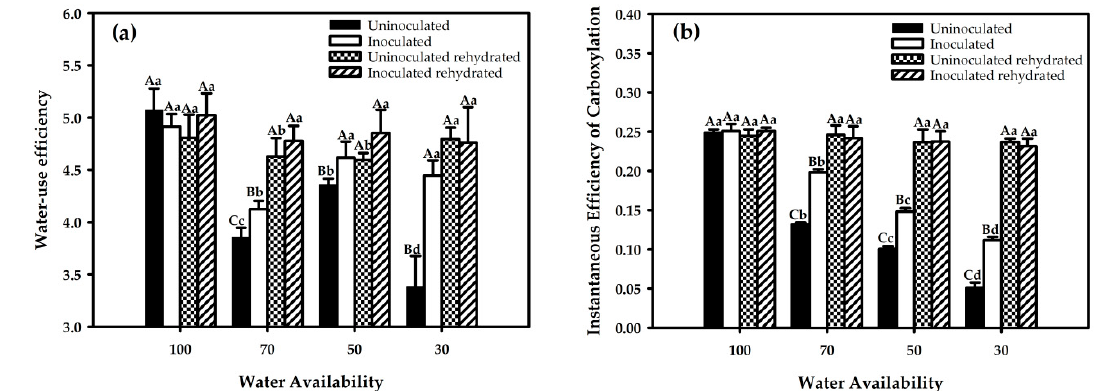
Figure 2. Gas exchange in red rice under different water restriction and inoculation conditions. Shown is of water-use efficiency ( a ) and instantaneous efficiency of carboxylation ( b ). Averages followed by identical capital letters do not differ in the inoculation condition for each soil water treatment, and averages followed by identical lowercase letters do not differ in the percentage of soil water. Bars represent the standard error (n = 3).